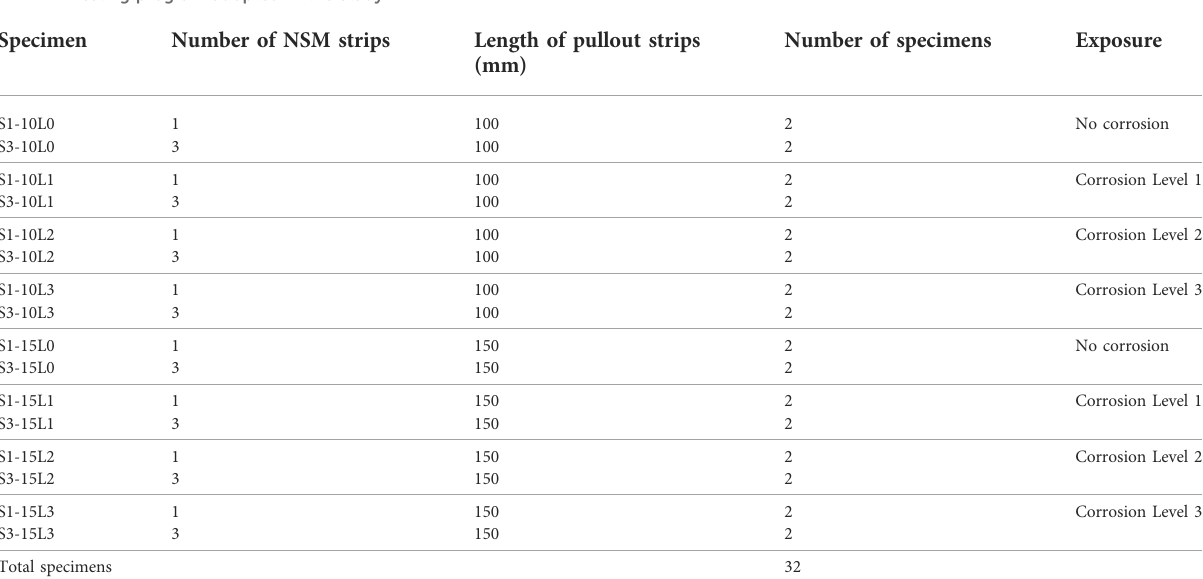
TABLE 1 Testing program adopted in the